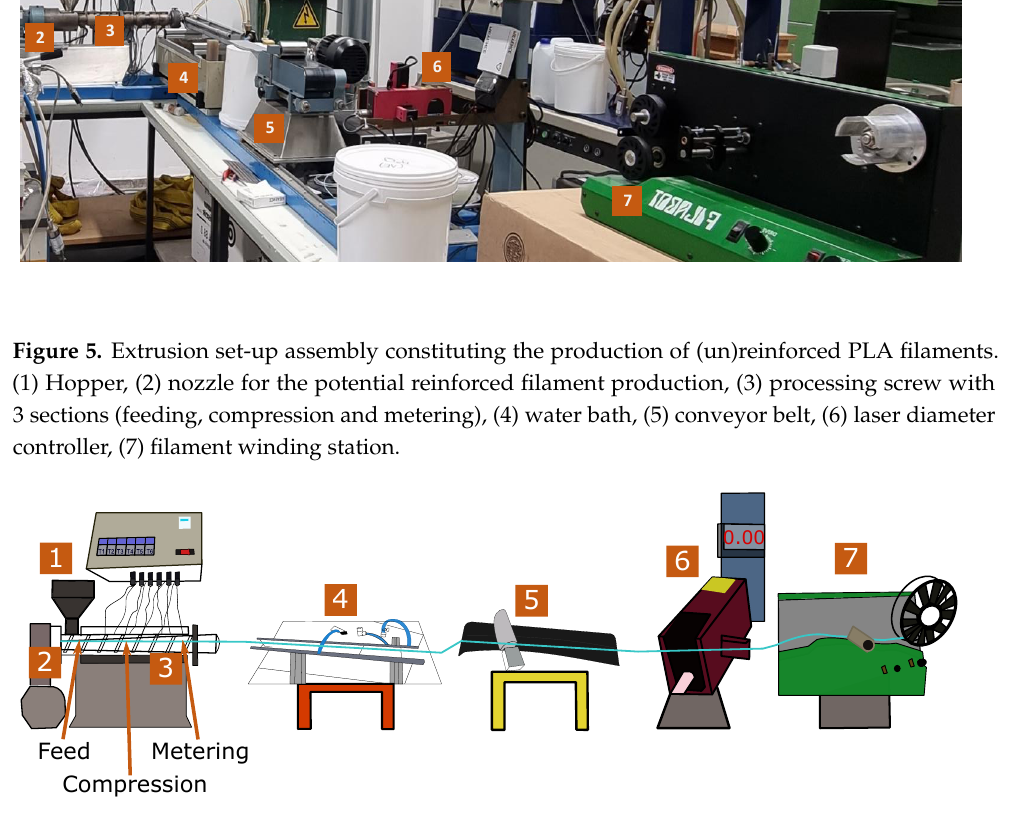
Figure 6. Schematic diagram of the filament production: Extrusion set-up assembly constituting the production of (un)reinforced PLA filaments. (1) Hopper, (2) nozzle for the potential reinforced filament production, (3) processing screw with 3 sections (feeding, compression and metering), (4) water bath, (5) conveyor belt, (6) laser diameter controller, (7) filament winding station. Table 6. Extrusion temperature profile for the extruder-screw. The entire screw is temperature controlled in each segment/zone separately. The matrix material A, PLA Luminy L130. Luminy L130 has T g 60°C and T m